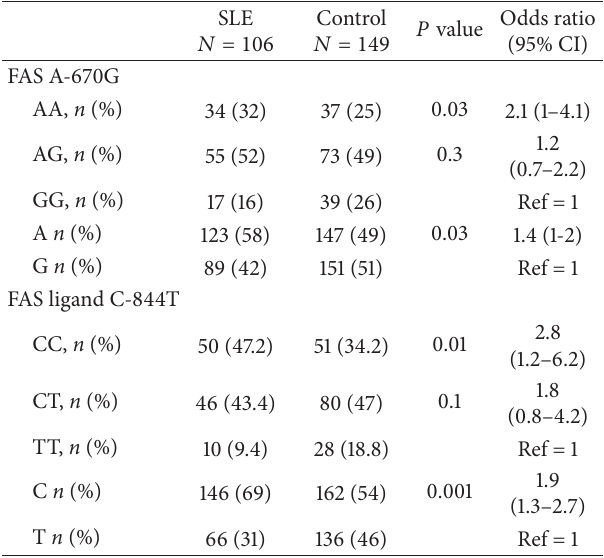
Table 3: Genotype and allele frequencies of FAS A-670G and FASL C-844T polymorphisms in SLE patients and